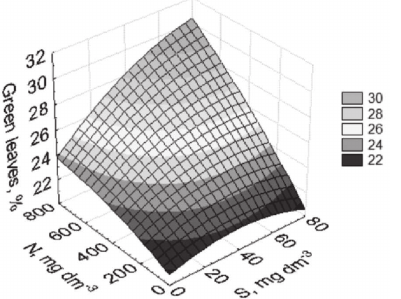
Green leaves (%) = 20.8463 + 0.0502*S + 0.0062*N - 0.0007*S + 0.0001*S*N - 3.1865x10 *N R = 0.57 Critical point not found.